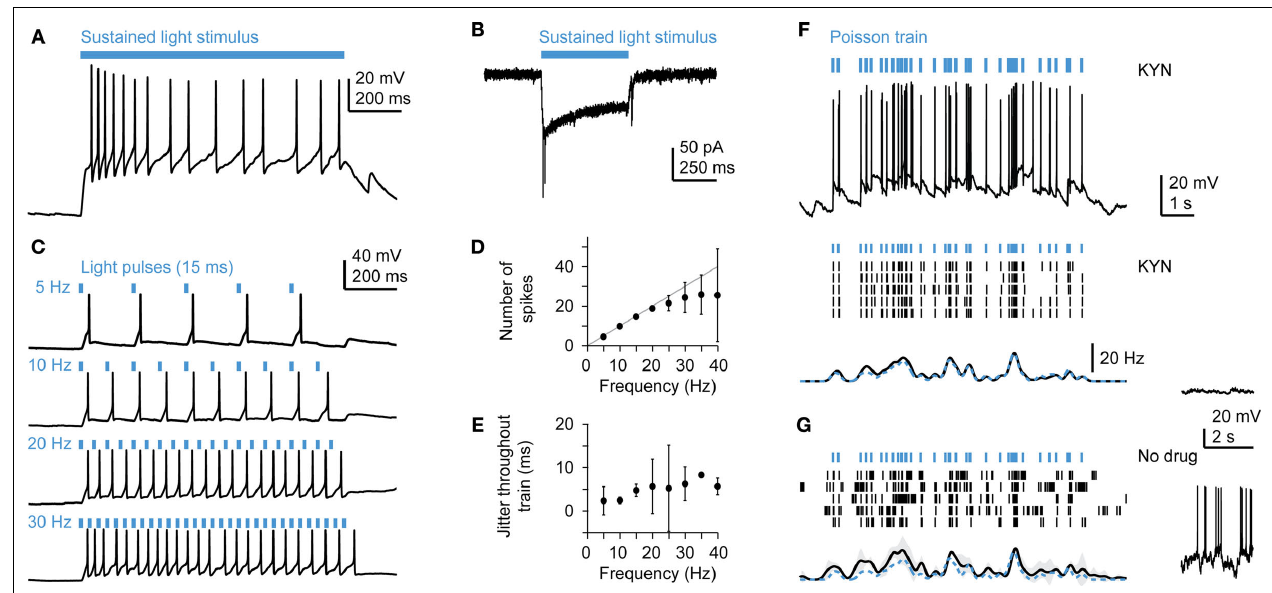
FIGURE 5 | Optical manipulation of neuronal activity in Tet system transgenics expressing channelrhodopsin-2. (A) Response of a mitral cell to prolonged illumination with blue light in current clamp. (B) Response of a mitral cell to blue light stimulation in voltage clamp. (C) Responses of a mitral cell to trains of light pulses (15 ms) at constant frequencies. Other mitral cells showed very similar responses ( n = 3). (D) Number of action potentials (mean ± SD) evoked by regular trains of light pulses as a function of frequency, averaged over n = 3 mitral cells. (E) Jitter of action potential timing (mean ± SD) as a function of frequency, averaged over n = 3 mitral cells. (F) Responses to Poisson trains of light